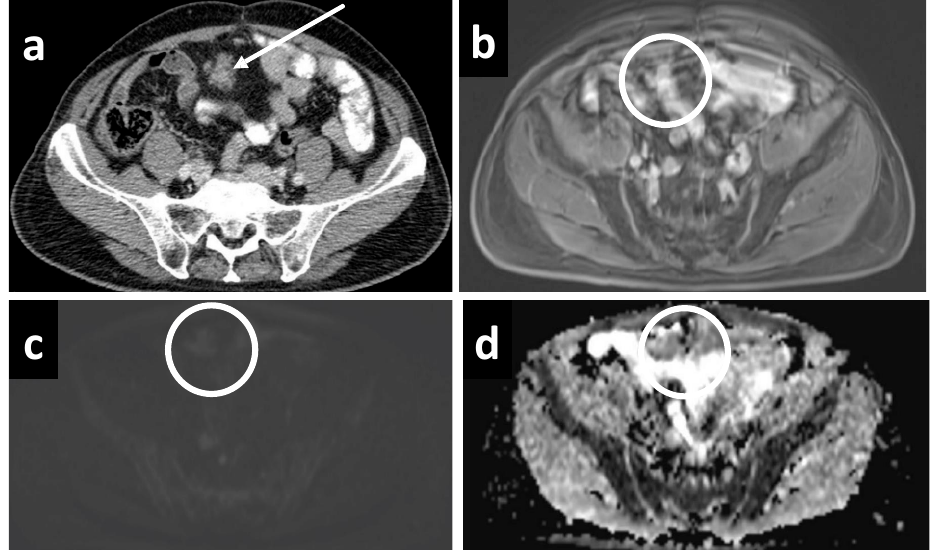
Figure 10. A fairly large soft tissue density peritoneal deposit is well seen on ( a ) CT, as it is surrounded by hypodense fat. Despite its large size, it is obscured on MRI with ( b ) delayed, ( c ) DWI, and ( d ) ADC sequences, primarily due to motion artifacts.